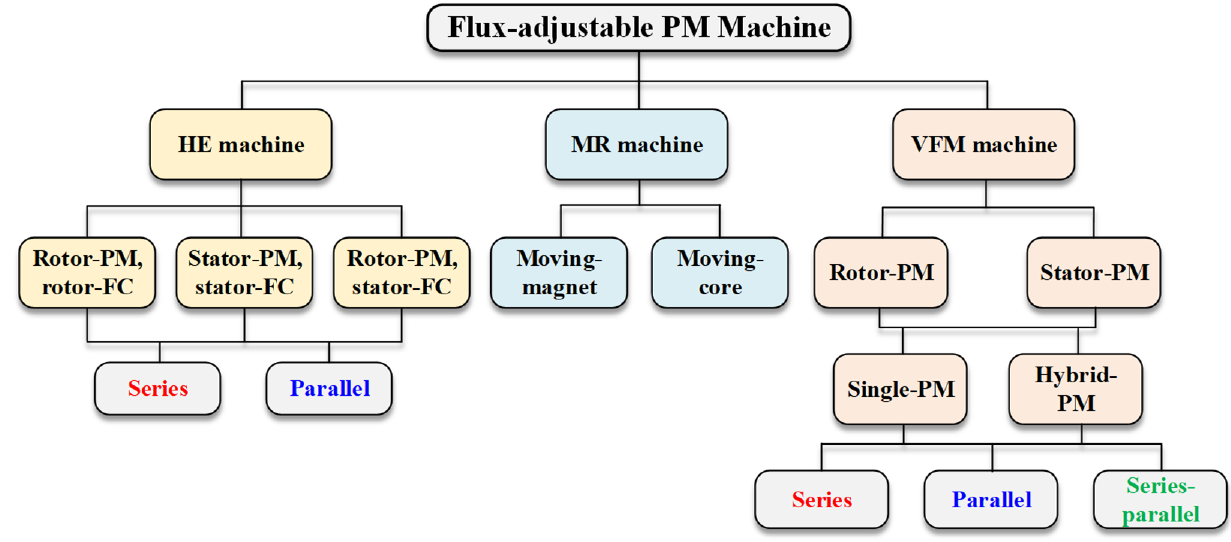
Figure 1. Classification of the flux ‐ adjustable PM machines.